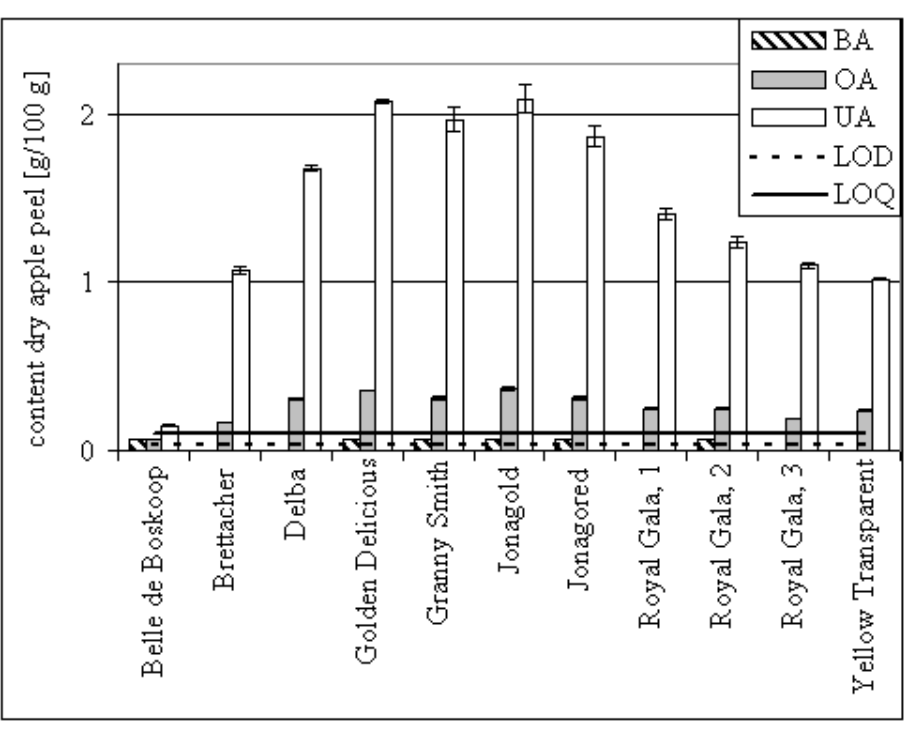
Figure 3. Triterpene acid content of dried apple peels. Error bars: ± standard deviation